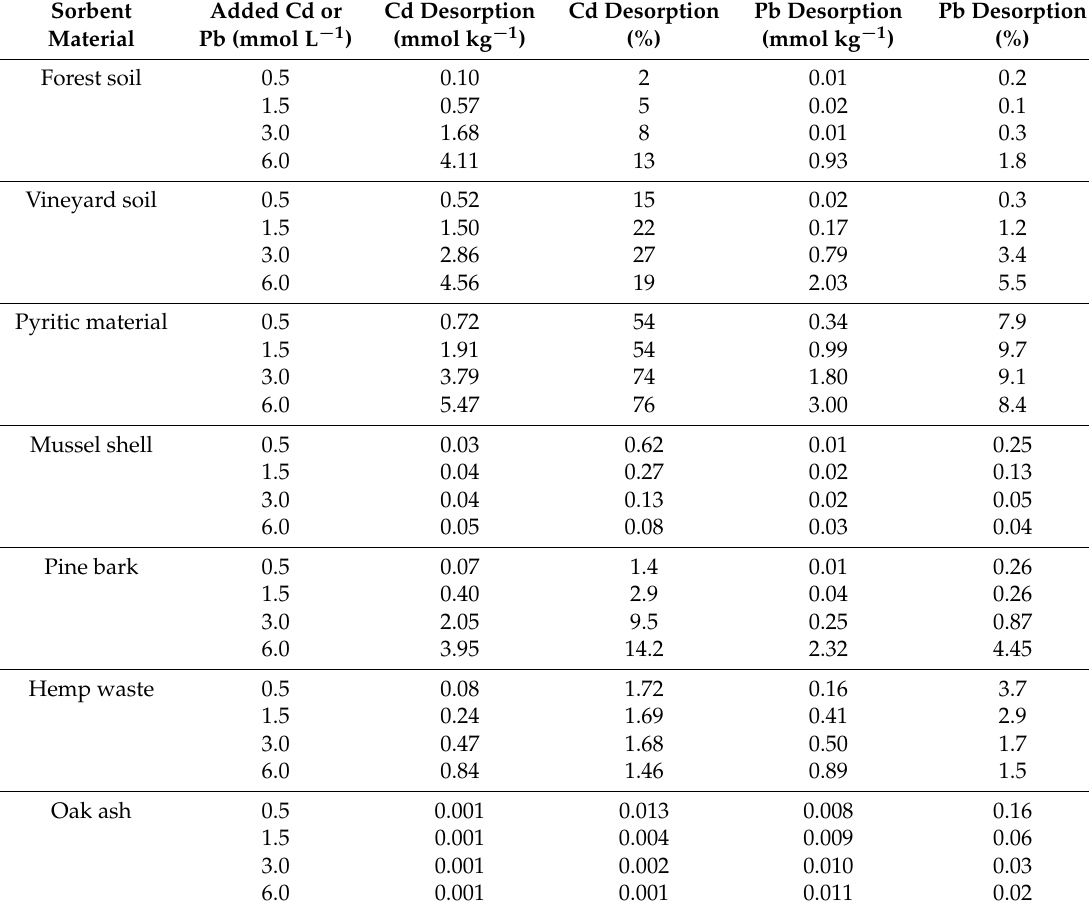
Table 3. Cd and Pb desorption (mmol kg − 1 and %) from the forest soil, vineyard soil, pyritic material and by-products studied. Average values for three replicates, with coefficients of variation always